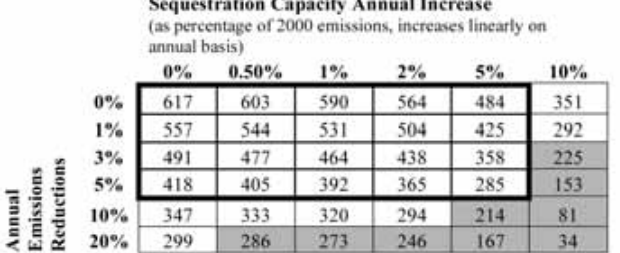
Table 1: Cumulative global emissions by 2050 with thirteen minimal nations in agreement. Values in white fall below the cumulative emissions cap of 290 Gt C required to avoid further dangerous climate change. Th e grey box indicates sequestration and emission reductions within reasonable bounds of technical